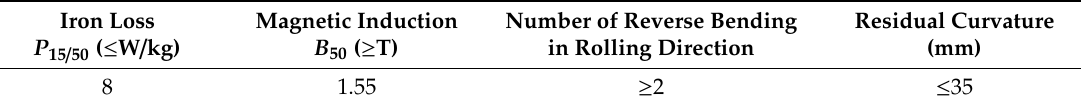
Table 5. Magnetic and mechanical properties of non-oriented silicon steels.